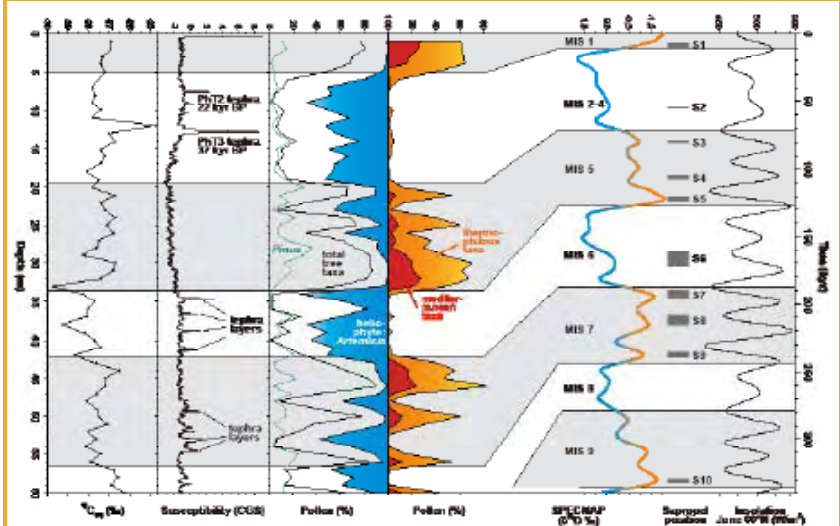
Figure 3. First results from the new core, comprising palynological, magnetic susceptibility and carbon isotope data. The tentative correlation of the pollen data with the SPECMAP chronology (Imbrie et al., 1984) and insolation values (Berger and Loutre, 1991) suggests that the record comprises at least the last 250 kyr. The magnetic susceptibility curve shows positions of PhT2 and PhT3 tephra layers and also indicates positions of older tephra